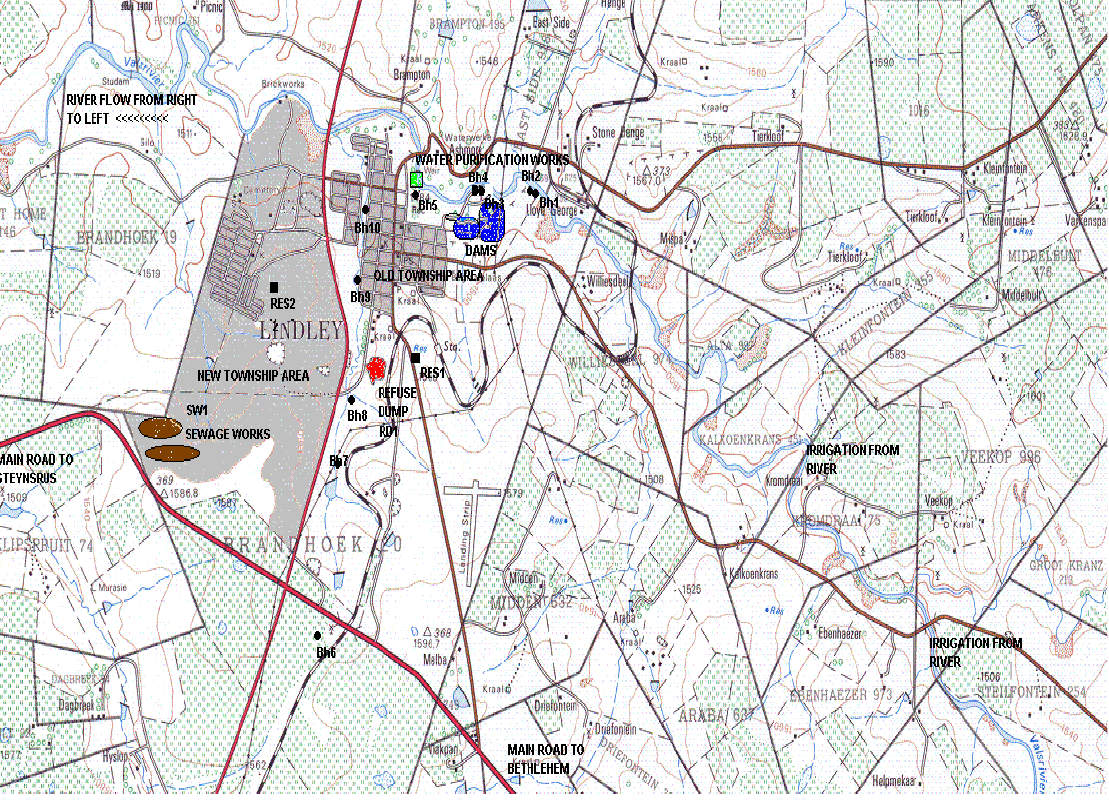
Figure 2: Lindley locality map (Source: Department of Land Affairs, 1987; Additions by authors,